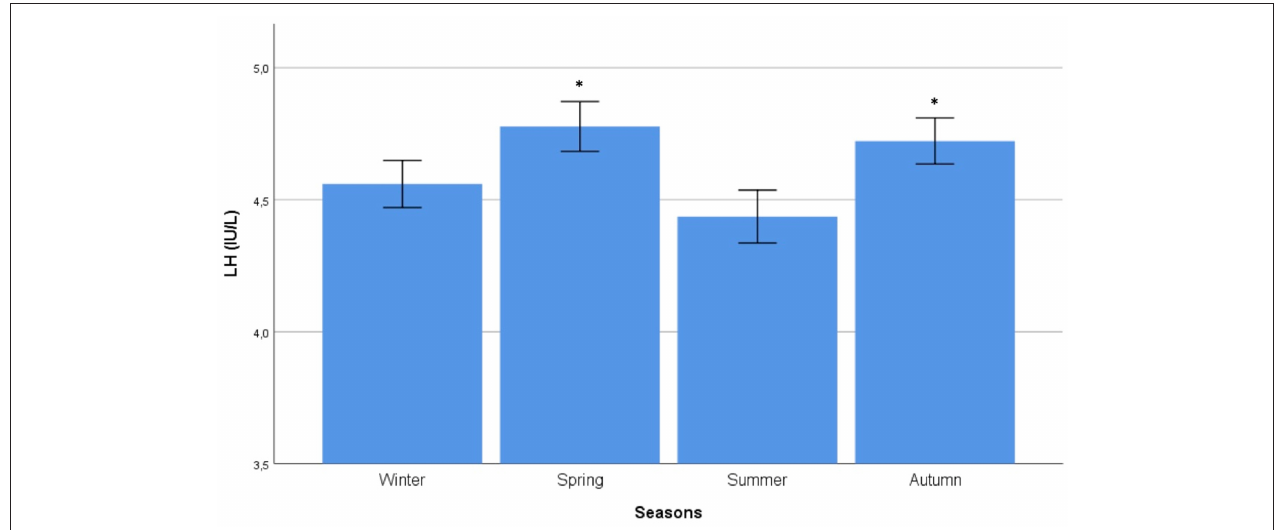
FIGURE 4 | Comparison of mean luteinizing hormone (LH) serum levels among seasons. Comparison was performed by Kruskal–Wallis test. *Identifies the highest LH serum levels at post hoc Tukey test.